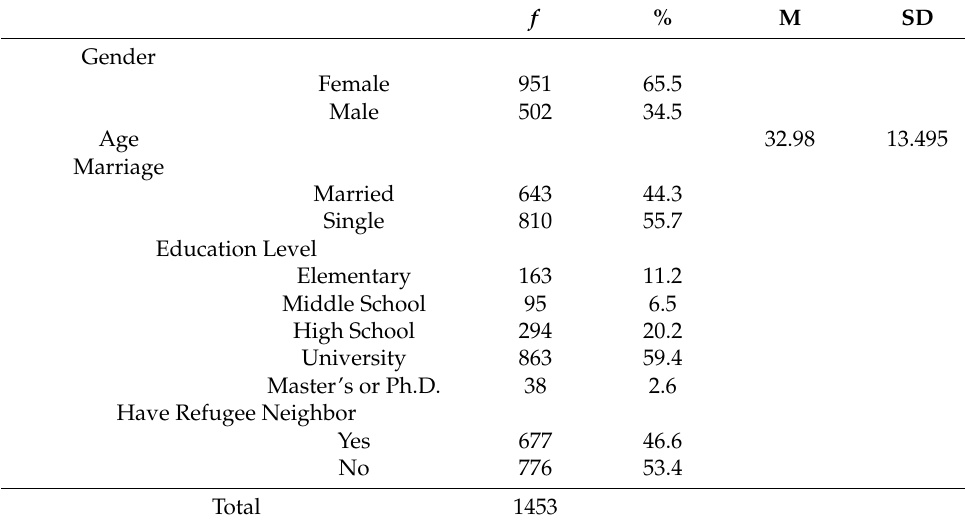
Table 1. Frequencies of sociodemographic